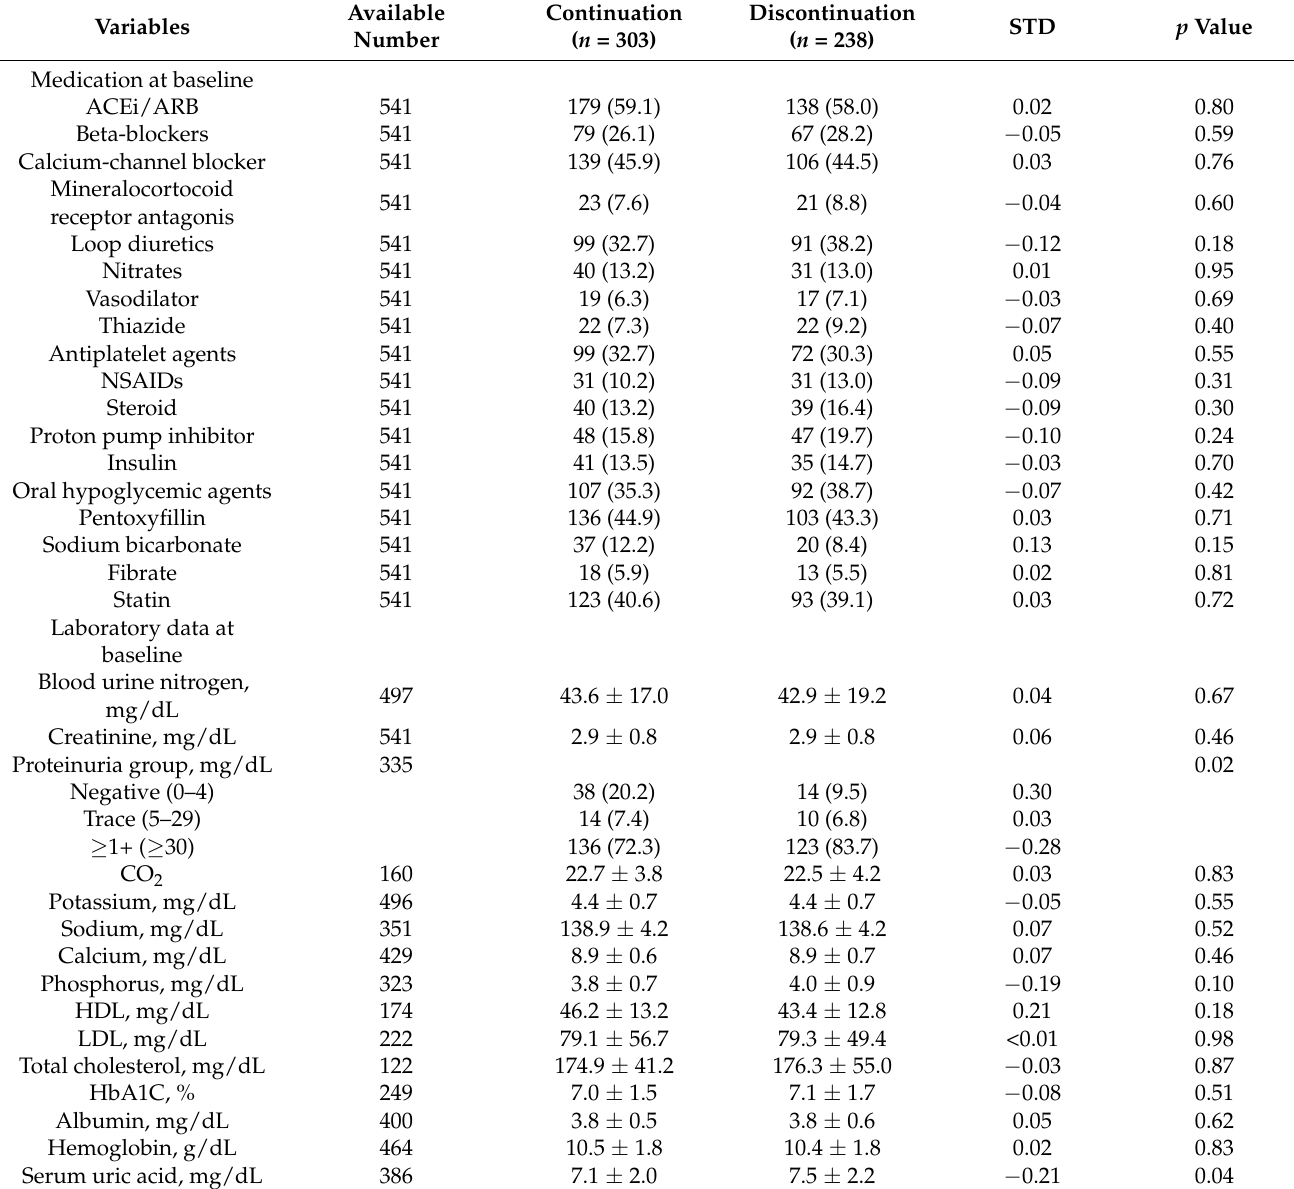
Table 2. Medication and laboratory data at baseline of patients receiving ketoanalogues supplemental low protein diet before IPTW and EM